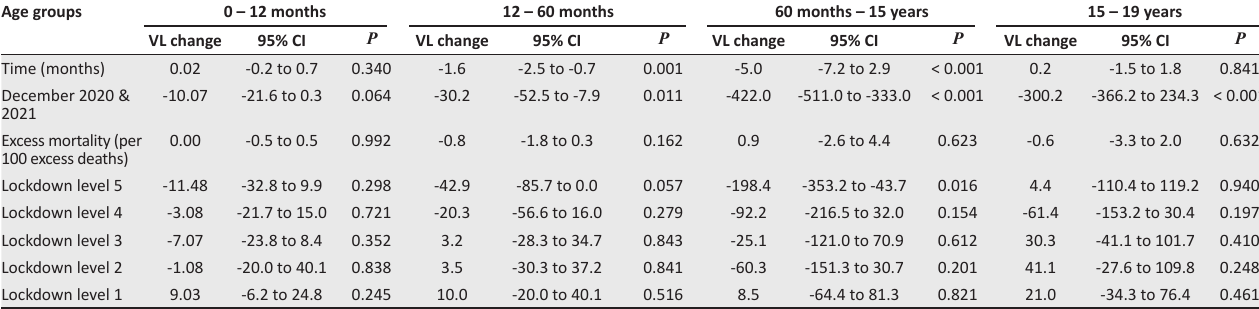
FIGURE 1: Trends in monthly viral loads among under-19-year-olds before and during COVID-19, and relationships with lockdown levels and excess mortality in eThekwini, South TABLE 3: Linear regression analyses of monthly viral loads stratified by age. Age groups